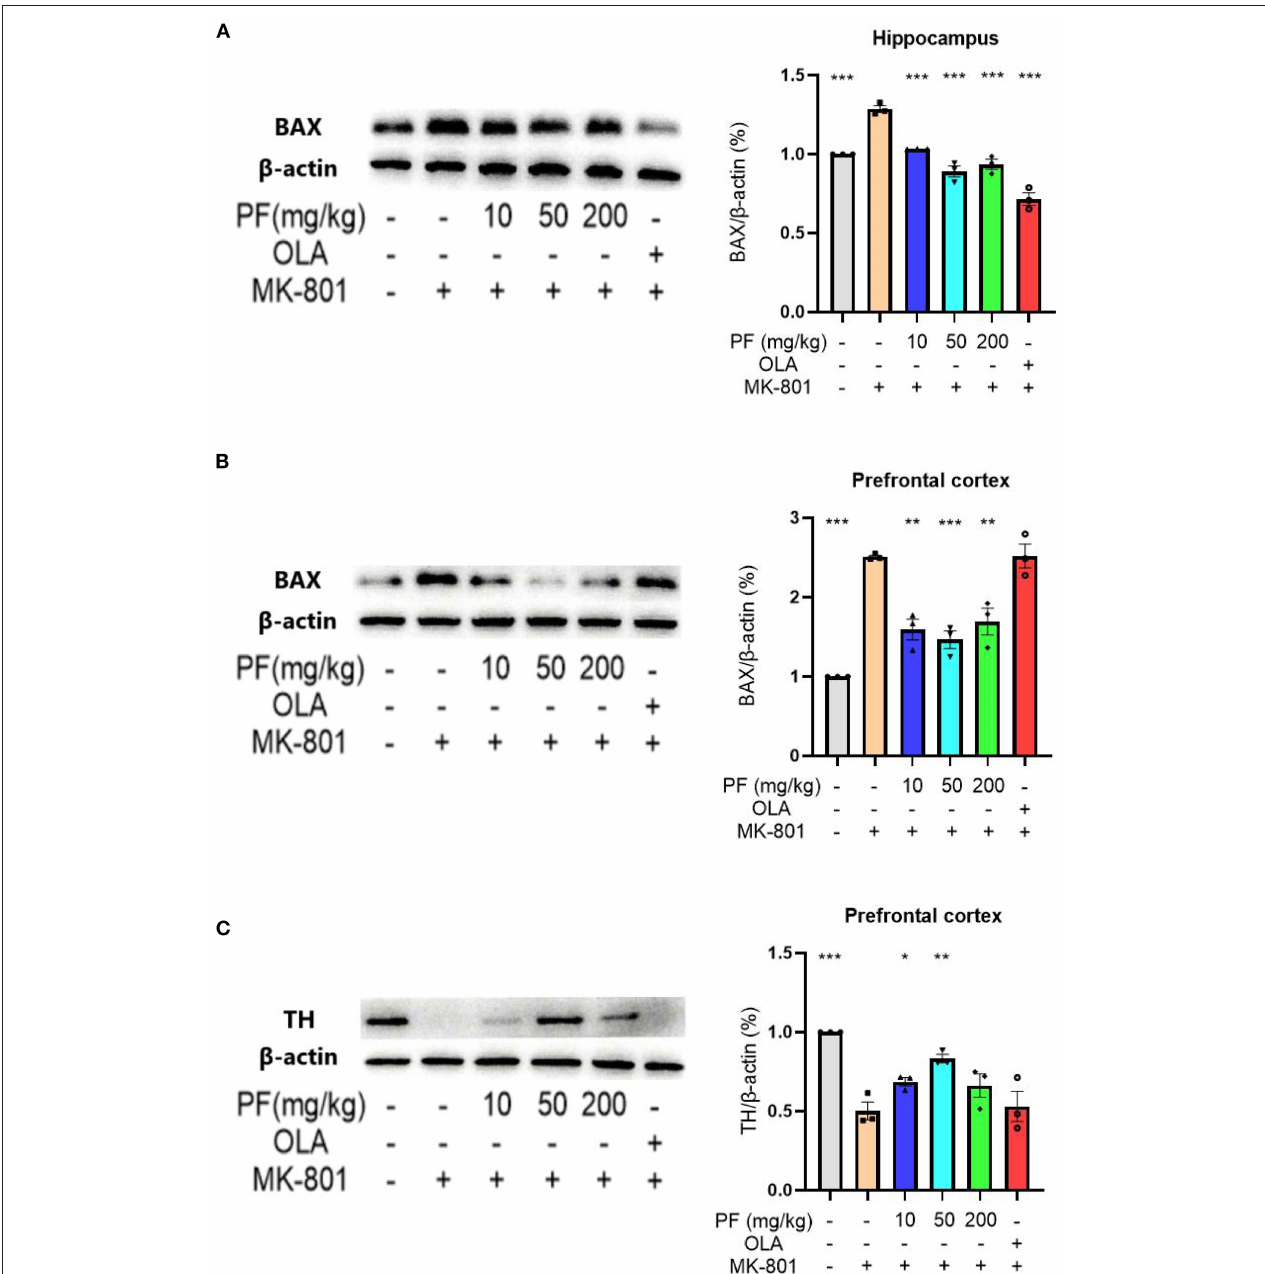
FIGURE 3 | Paeoniflorin (PF) ameliorated MK-801-induced apoptosis in the brains of mice. (A) Hippocampal Bax expression levels were significantly up-regulated in the MK-801-treated mice, while PF administration abolished this alteration. (B) PF administration significantly inhibited MK-801-induced Bax up-regulation in the prefrontal cortex. Olanzapine treatment in the model mice significantly down-regulated Bax levels in the hippocampus, but not in the prefrontal cortex. (C) 10 mg/kg and 50 mg/kg, but not 200 mg/kg PF treatment significantly increased tyrosine hydroxylase levels in the MK-801 model mice. Three-way ANOVA statistics: F A = 48.86, P < 0.001; F B = 26.87, P < 0.001; F C = 11.15, P < 0.001. Values are the mean ± SEM, n = 3/group. * p < 0.05, ** p < 0.01, *** p <